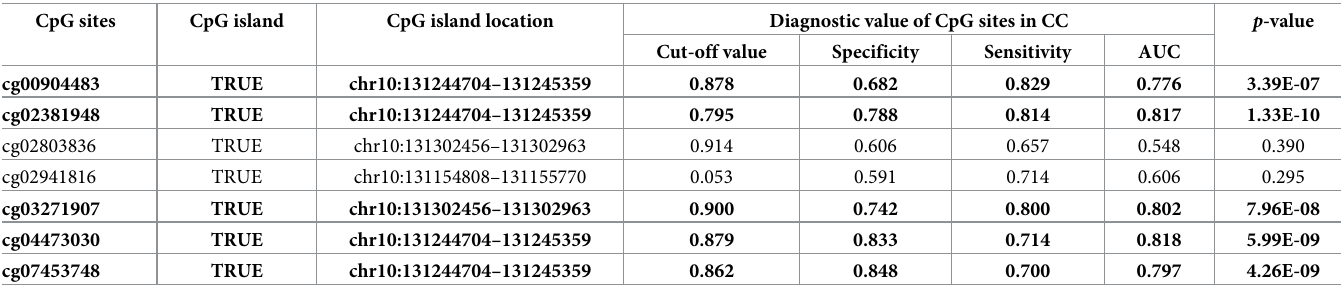
Table 7. Diagnostic value of 7 CpG sites of MGMT promoter for cervical